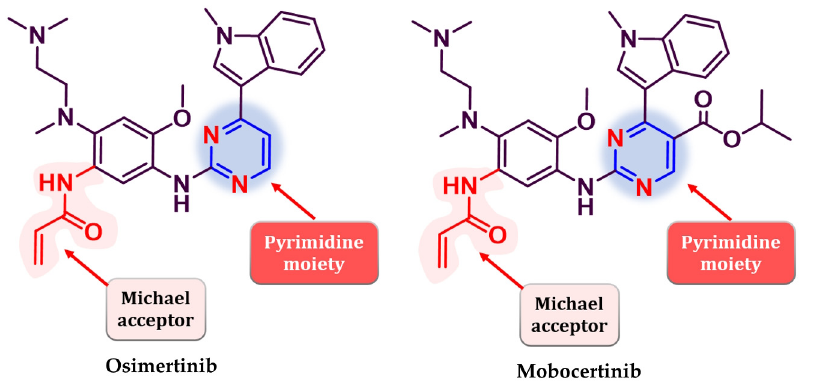
Figure 26. Chemical structure of third-generation EGFR approved in therapy: osimertinib andmob- ocertinib.